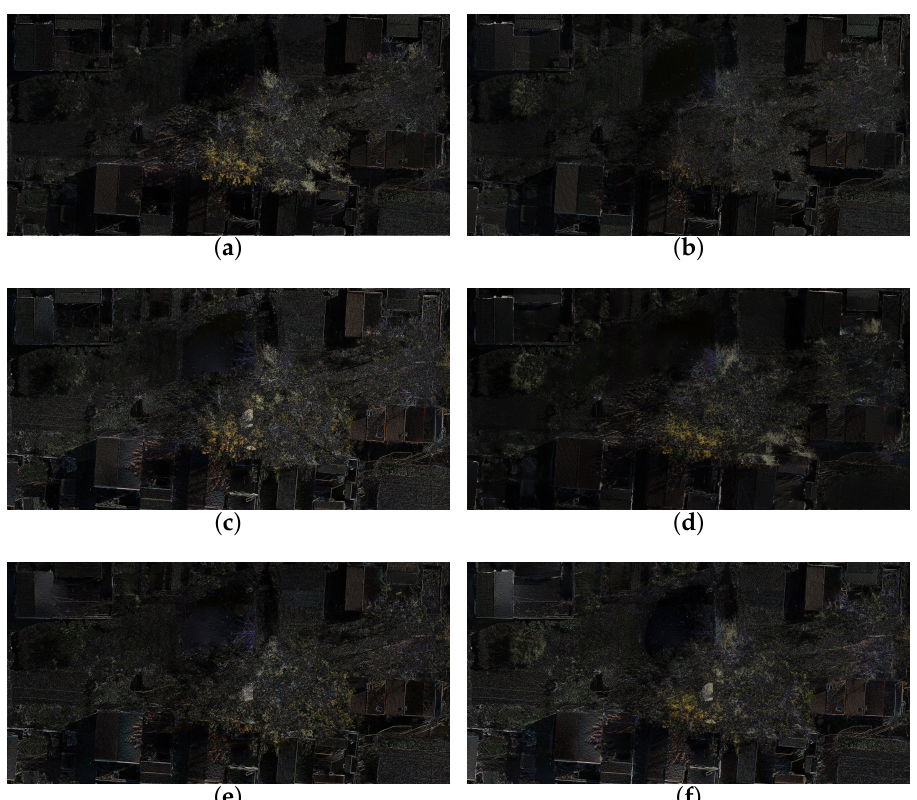
Figure 17. Color difference map between each of the two results. ( a ) Color difference map between ContextCapture and TDM. ( b ) Color difference map between Pix4D and TDM. ( c ) Color difference map between Altizure 3D and TDM. ( d ) Color difference map between ContextCapture and Pix4D. ( e ) Color difference map between ContextCapture and Altizure 3D. ( f ) Color difference map between Pix4D and Altizure 3D.